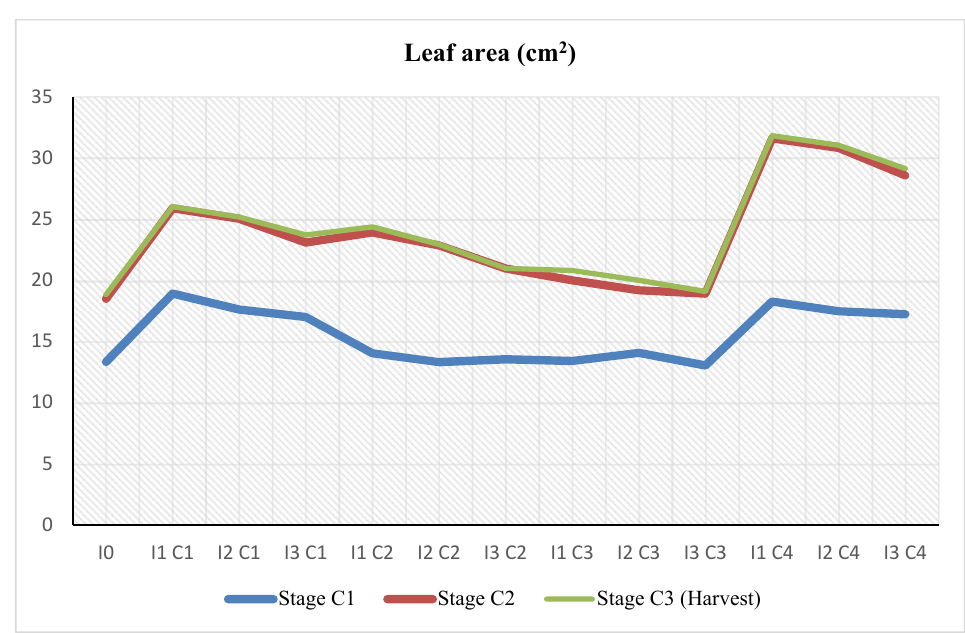
Figure 5. Change in leaf area during various crop phenological stages in response to different levels of irrigation.